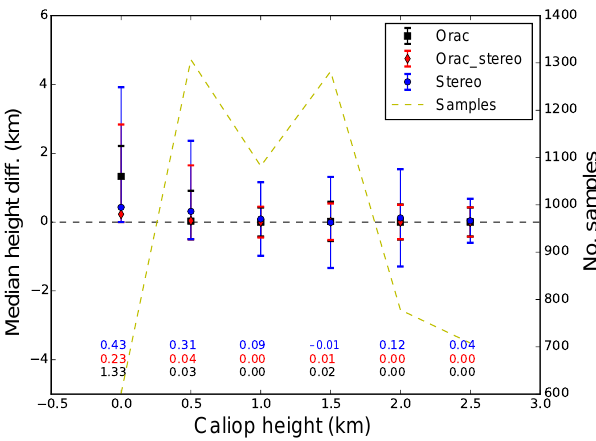
Figure 7. Error bar plot plotting the median height differ- ences for single-layer water clouds (over water where ORAC and ORAC + stereo phase agrees) below 3km (as determined by CALIOP) for the three algorithms applied to AATSR and the el- evation of the CALIOP CTL, as a function of the elevation of the CALIOP CTL at 500m intervals (in this instance the median is de- rived from all collocated data contained within set given by the CALIOP CTL elevation indicated on the x axis and all CALIOP CTL samples which are located within the following 500m, e.g. 0km ≤ CTL<0.5km). The three statistics below each error bar are the median differences. The error-bar whiskers represent 1 standard